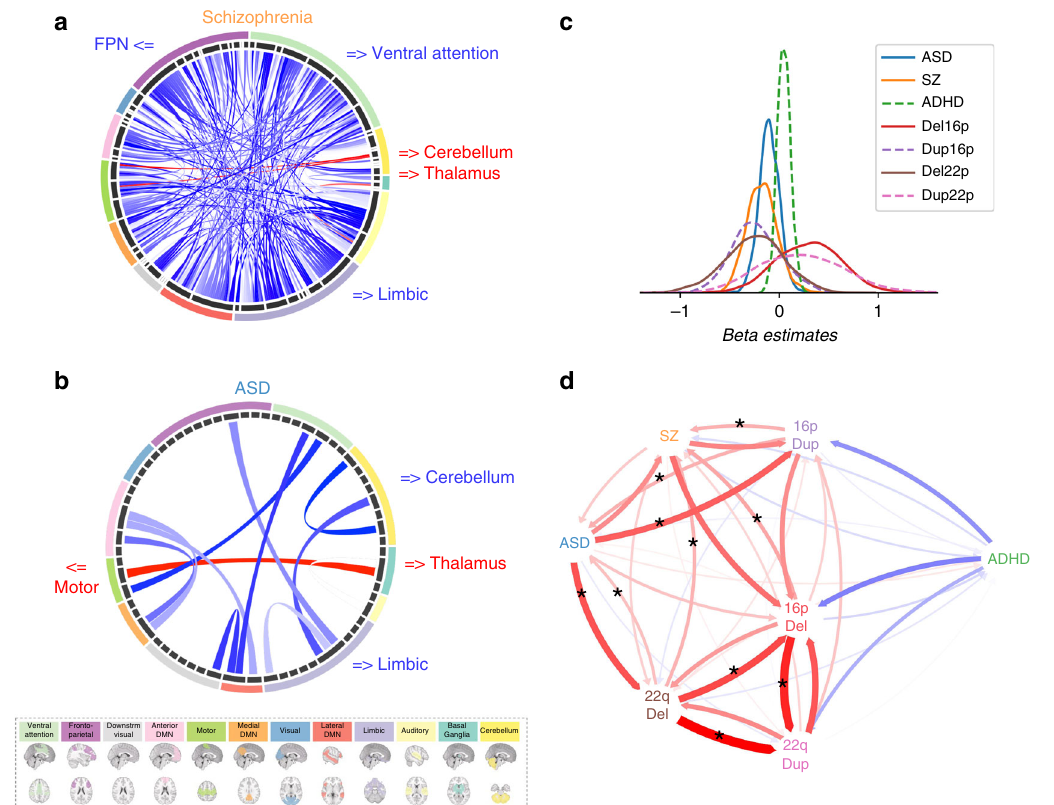
Fig. 2 Connectome-wide similarity across ASD, SZ, and deletions. a , b Each chord diagram shows the top 20% connections surviving FDR correction ( q < 0.05) from the SZ ( a ) and ASD ( b ) CWAS. Each chord represents a signi fi cantly altered connection between two functional seed regions. All 64 seed regions are represented in the dark gray inner circle. The width of the seed region in the gray inner circle corresponds to the number of altered connections. Seed regions are grouped into 12 functional networks (outer ring, Supplementary Data 1.9). The network colors correspond to the legend below. Red chords represent overconnectivity and blue chords underconnectivity. c Density plots represent the distribution of 2080 beta estimates for the CWAS (whole brain contrast of cases versus controls) for the SZ, ASD, ADHD, deletion and duplication groups. X -axis values = z-scores of Beta estimates, which were obtained from linear models computed using z-scored connectomes based on the variance of the respective controls. d The spatial similarity of whole-brain FC-signatures between CNVs and idiopathic psychiatric conditions. Arrows represent the correlation between group-level FC-signatures and the individual connectomes of either cases or controls from another group. The correlation was computed in both directions. The Red and blue arrows represent positive and negative correlations respectively. Arrow thickness represents the effect size of the Mann – Whitney test. Stars represent similarities (Mann – Whitney tests) surviving FDR. ASD autism spectrum disorder, SZ schizophrenia, ADHD attention-de fi cit hyperactivity disorder, FPN fronto-parietal network,